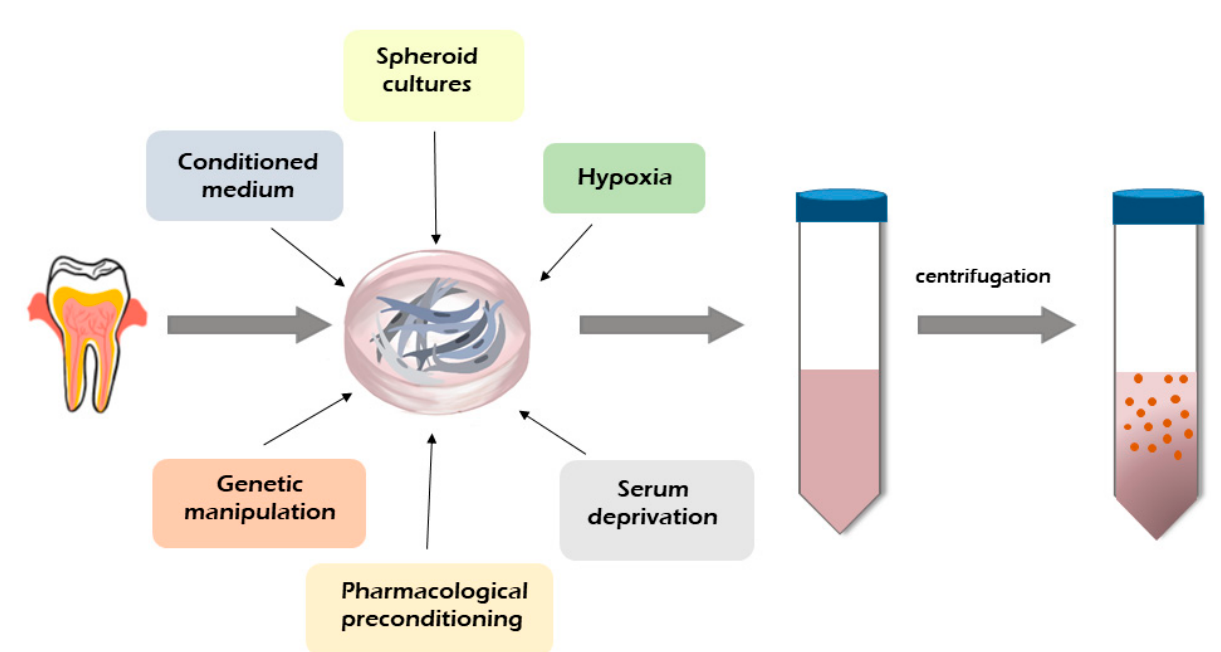
Figure 2. Dental MSC-derived secretome production and methods of its modification.